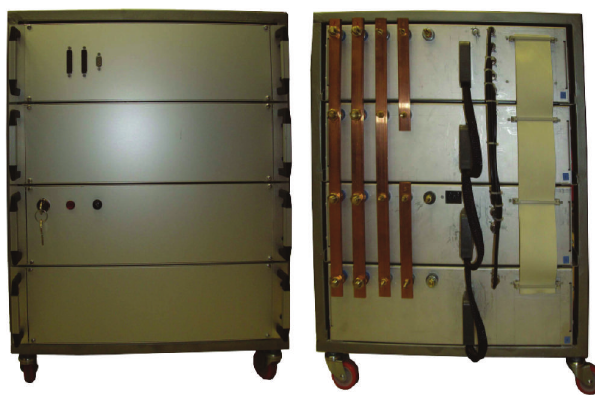
Figure 16: Assembled converter: front and rear.